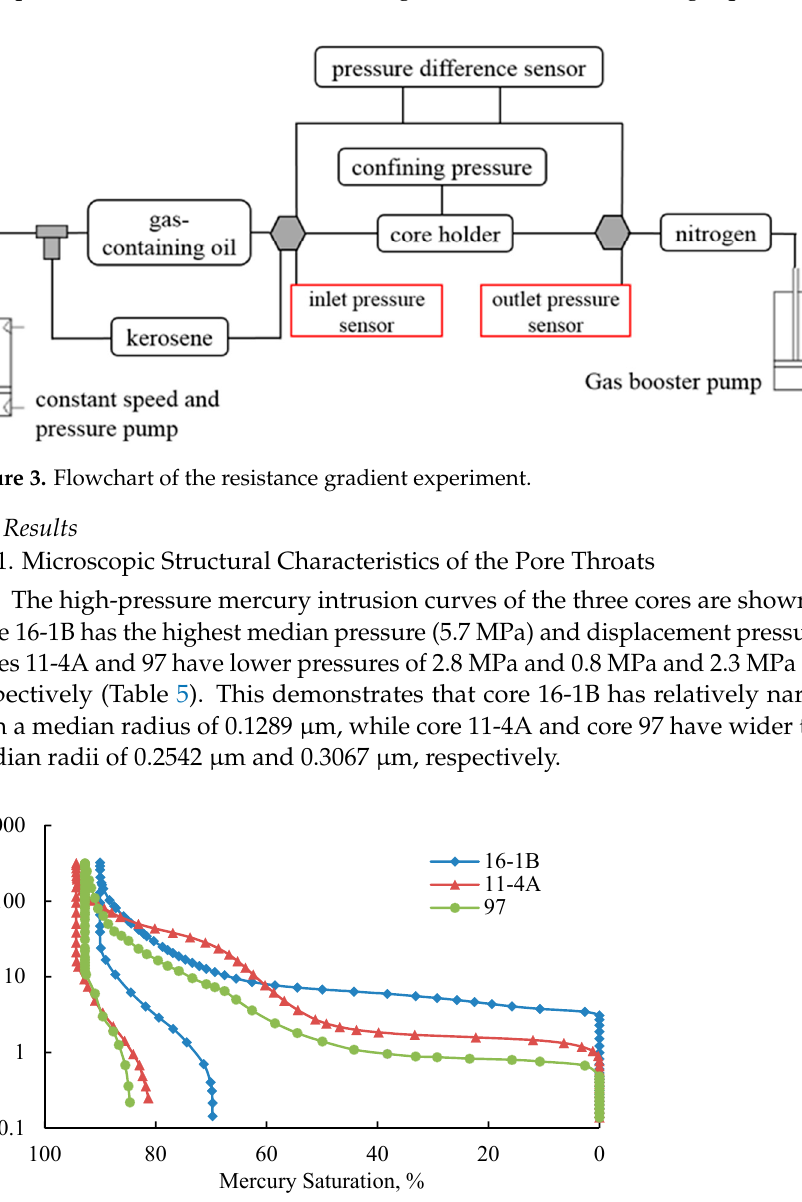
Figure 2. A sketch of the Jamin effect.